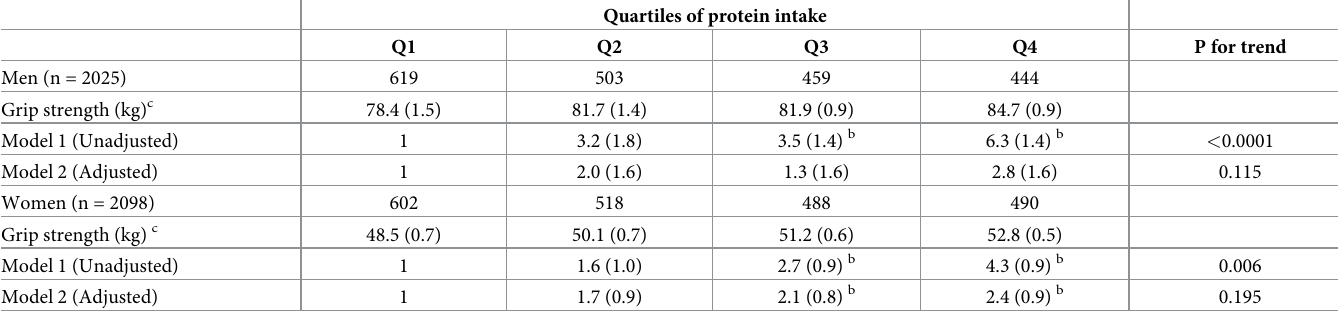
Table 5. Association between grip strength and daily protein intake before and after adjusting for potential confounders a .